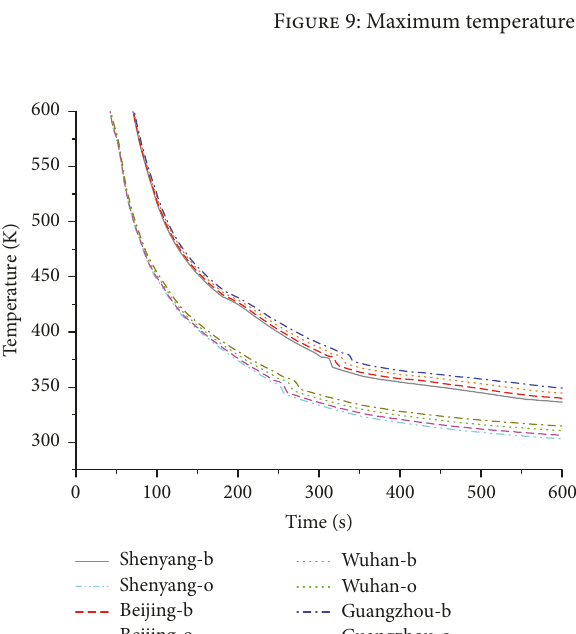
Figure 9: Maximum temperature attenuation curves of different TBX mass.